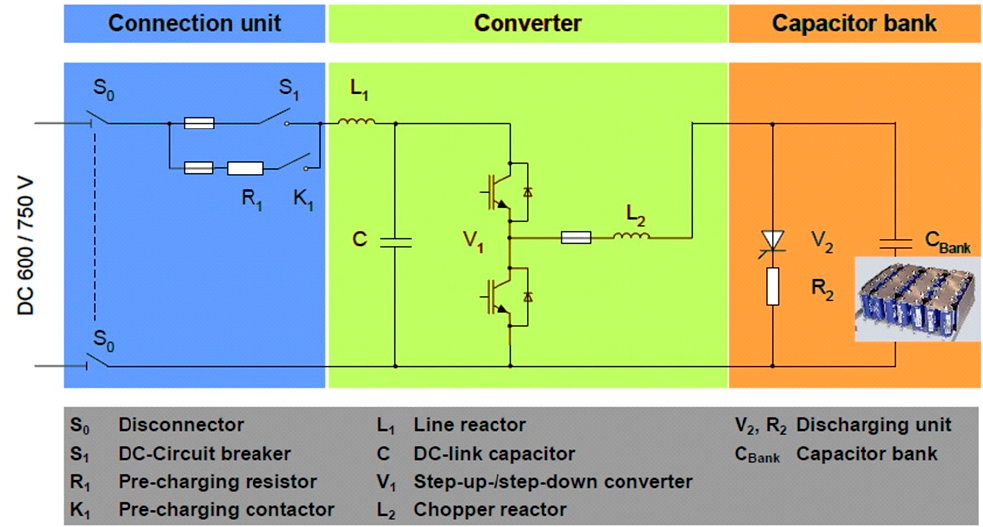
Figure 2. Classic bidirectional DC/DC converter for an energy storage device.